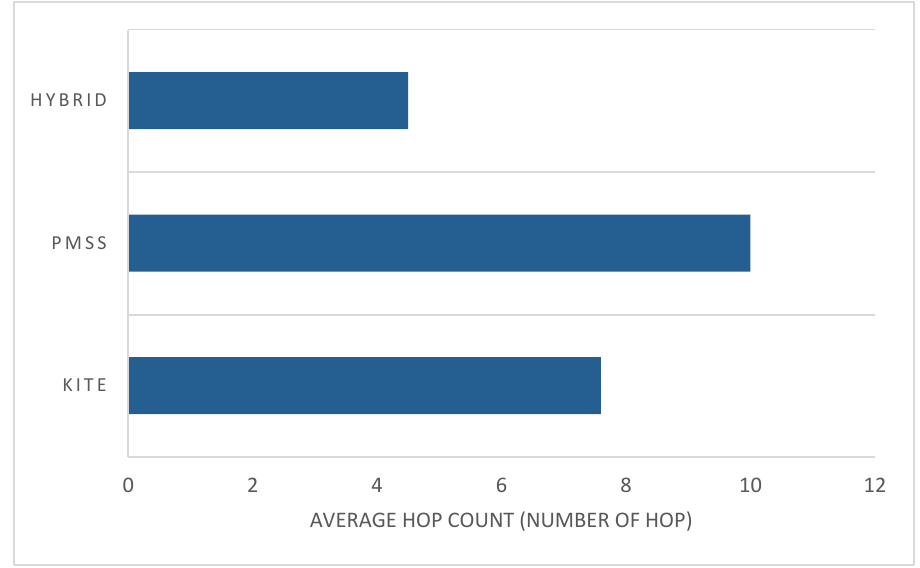
Figure 12. Average hop count by each method.